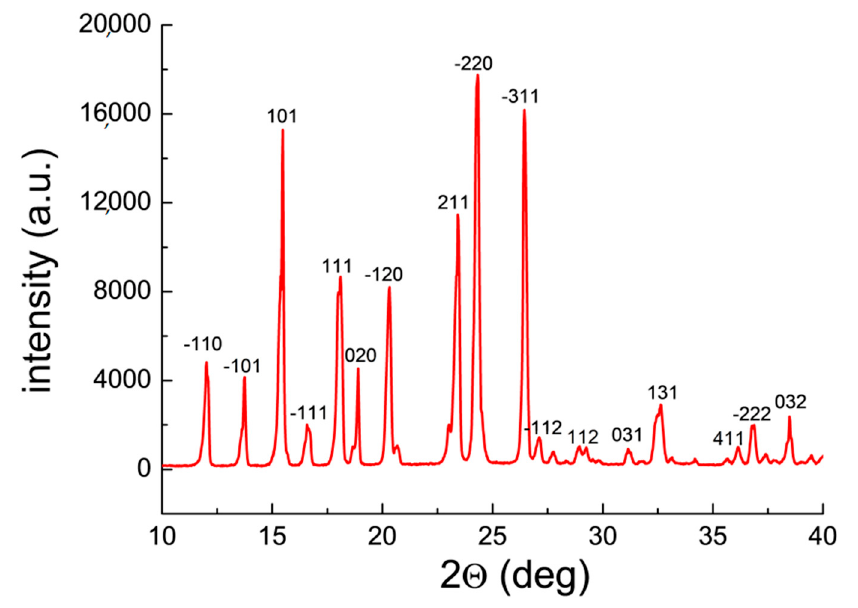
Figure 2. Diffraction pattern of pure acetaminophen API. Table 1. Comparison of experimental data with data from ICDD database for pure ACP (C 8 H 9 NO 2 ).